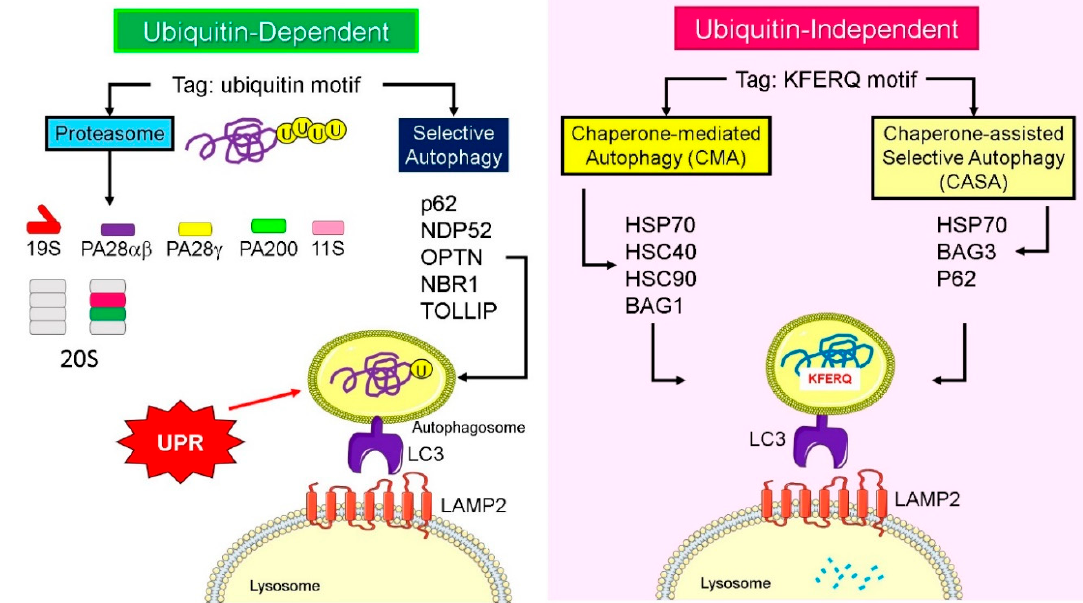
Figure 4. Adaptation for ubiquitin-dependent and -independent protein degradation. Combinations of proteasomal regulatory particles and autophagy adaptor proteins and possible heat-shock proteins and Bcl-2-associated athanogene proteins that allow adaptation of the protein degradation machinery depending on the cellular needs. Ubiquitylated proteins can be recognized various types of regulatory particles or by adaptive proteins that allow lysosomal degradation. Proteins with a specific recognition motif are either recognized by the chaperone-mediated (CMA) or chaperone-assisted selective (CASA) autophagy mechanisms to guide the cargo into the lysosomal degradation.